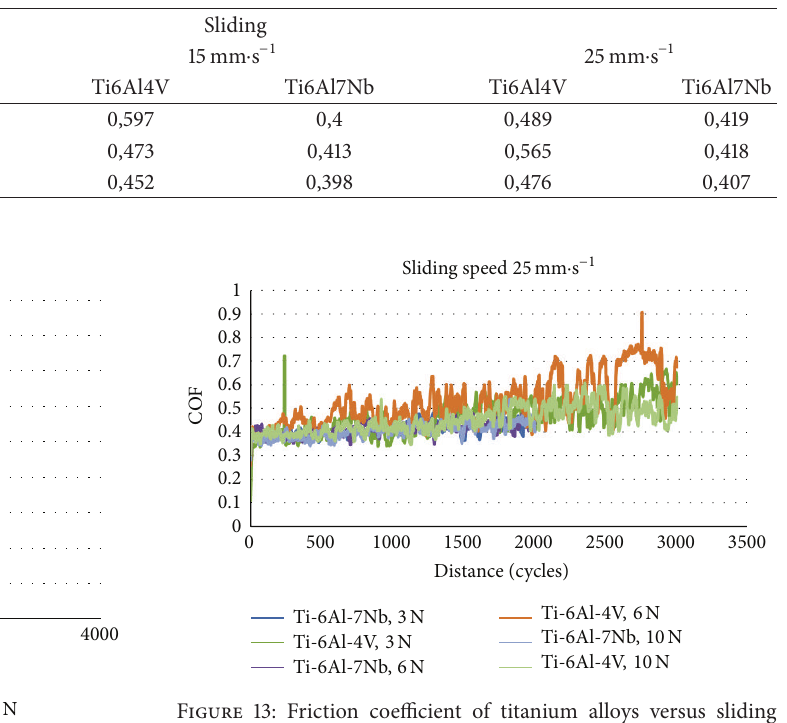
Figure 13: Friction coefficient of titanium alloys versus sliding distance under different conditions of loads at 25 mm ⋅ s −1